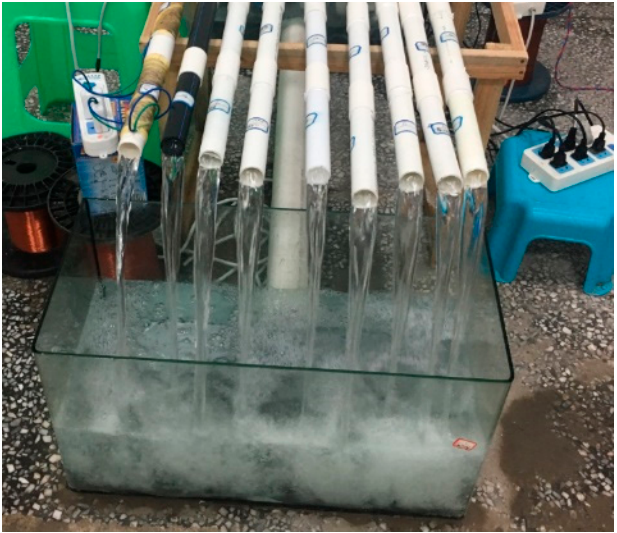
Figure 4. Indoor test operation. Table 1. Influencing factors of the tests.